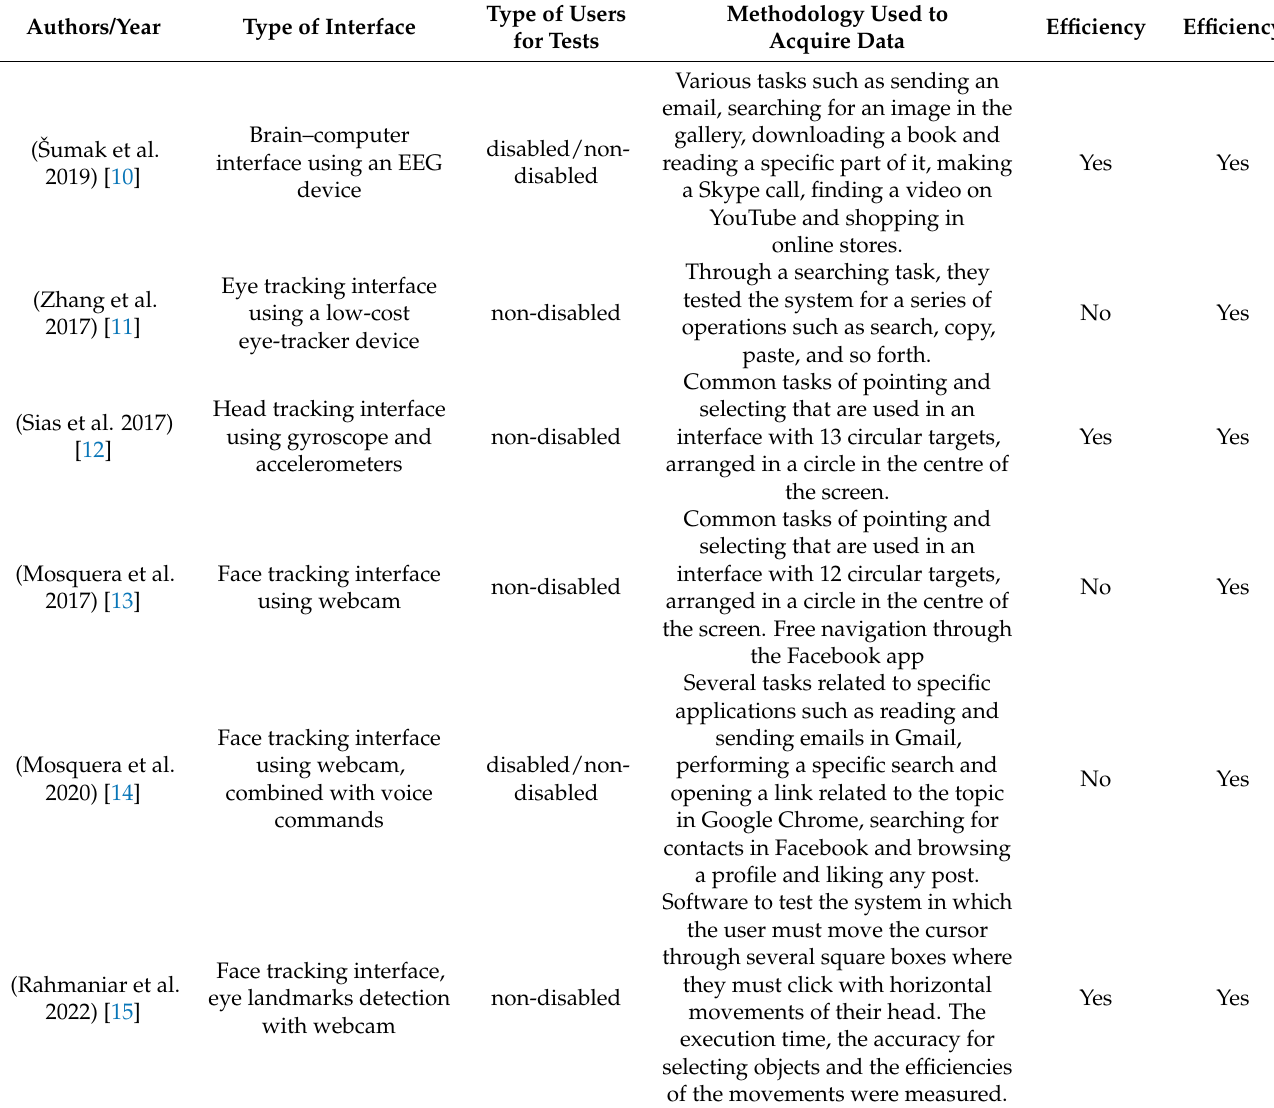
Table 11. Methodology used to acquire data for efficiency and effectiveness